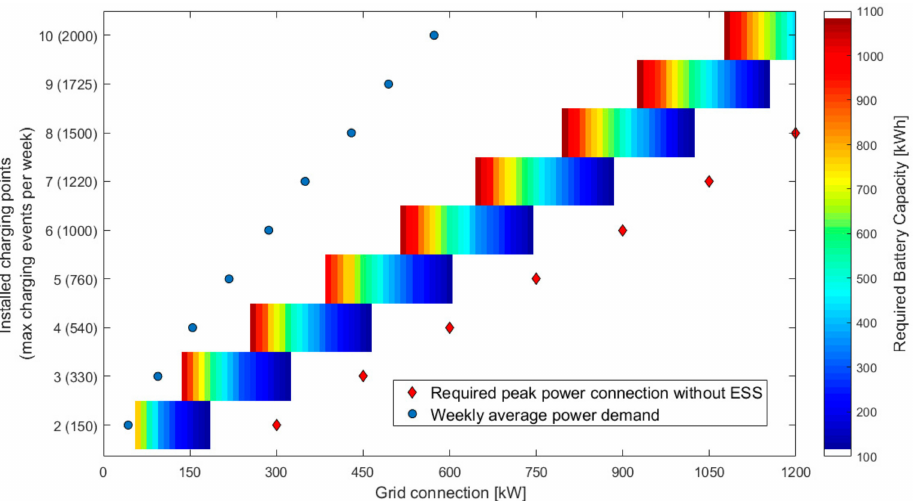
Figure 7. Required ESS capacity as a function of the available grid connection.